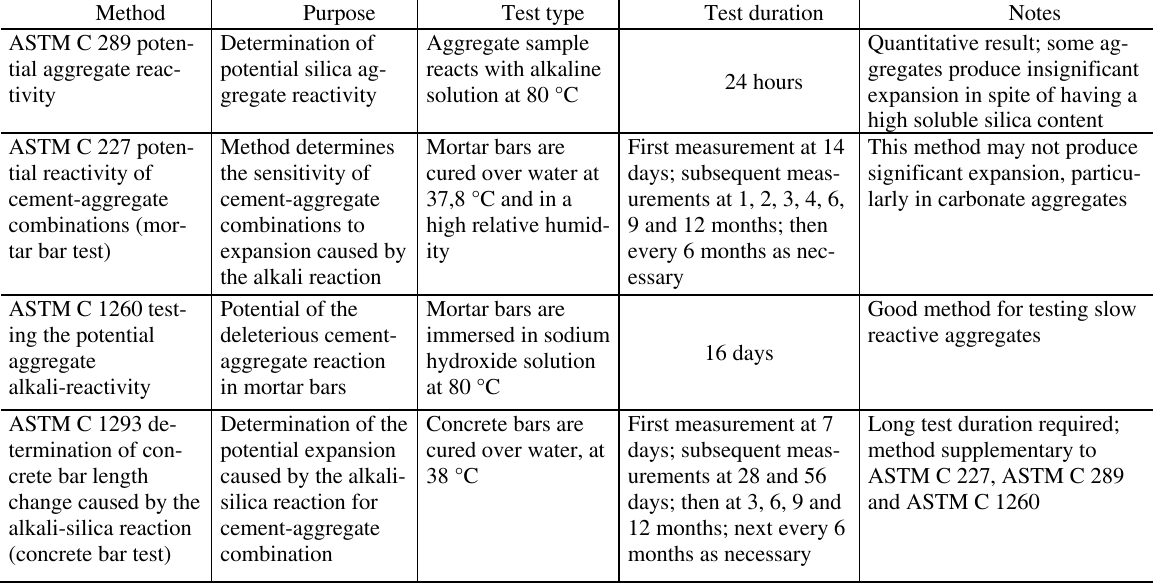
Table 1. Test methods for alkali-aggregate